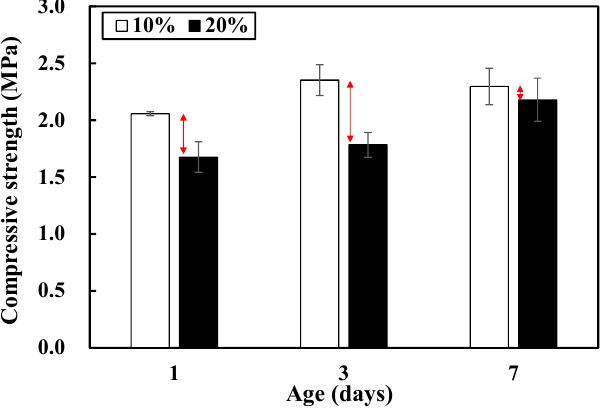
Figure 2. Compressive strength in different age and moisture content combinations.